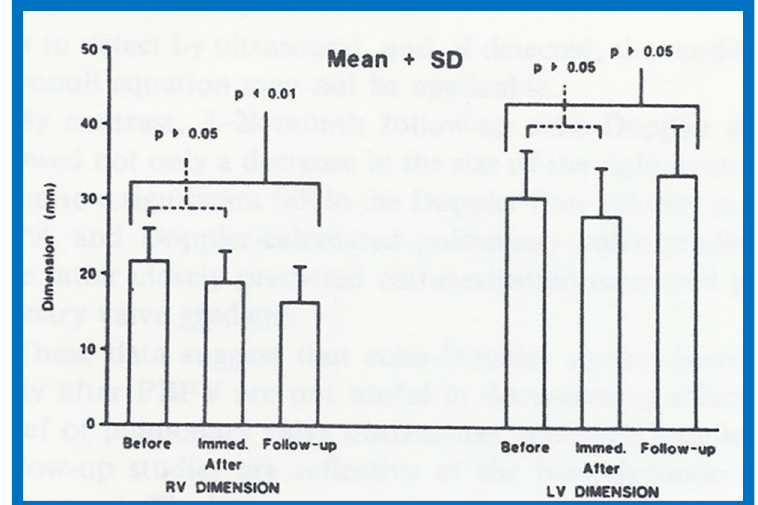
Figure 44. Bar graph showing right (RV) and left (LV) ventricular end-diastolic dimensions prior to (Before), immediately after (Immed. After) balloon pulmonary valvuloplasty and at a median follow-up of 14 months (Follow-up). Means and standard deviations (SD) are shown. Note that there is small but not statistically significant ( p > 0.05) decrease in RV dimension immediately after balloon pulmonary valvuloplasty, but at follow-up, there was a significant ( p < 0.01) decrease in RV dimension. There was no change ( p > 0.05) in LV dimension either immediately after balloon pulmonary valvuloplasty or at follow-up. Reproduced from Rao P.S. [13].